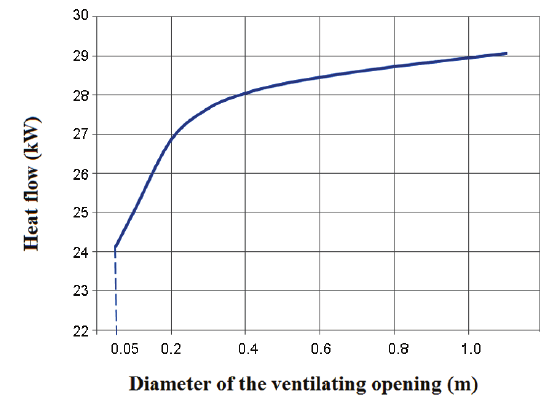
Fig. 12. Heat losses through the roof of the academic building